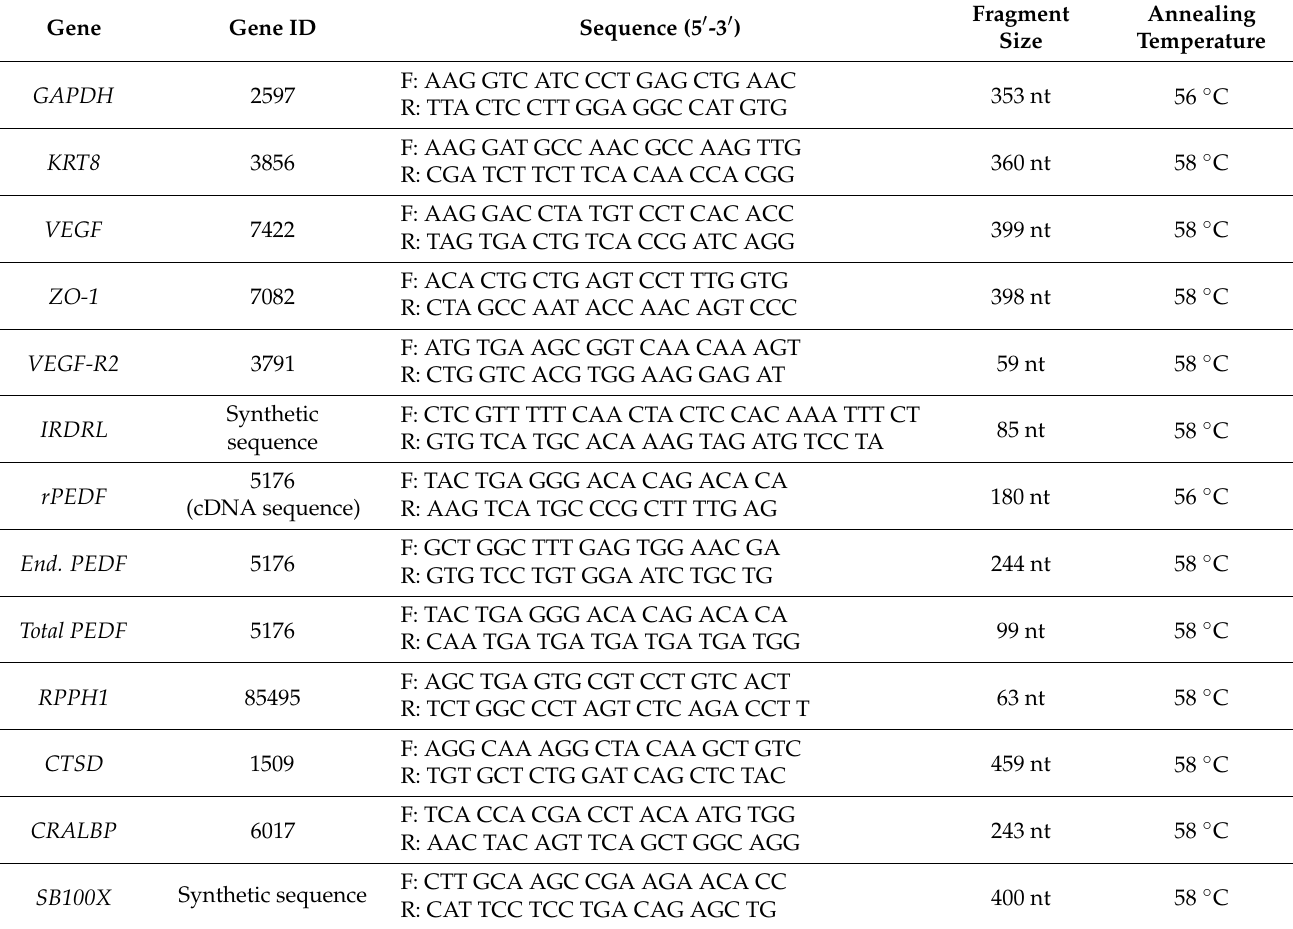
Table 1. Primer sequences used for PCR and qPCR analyses, resulting fragment sizes, and annealing